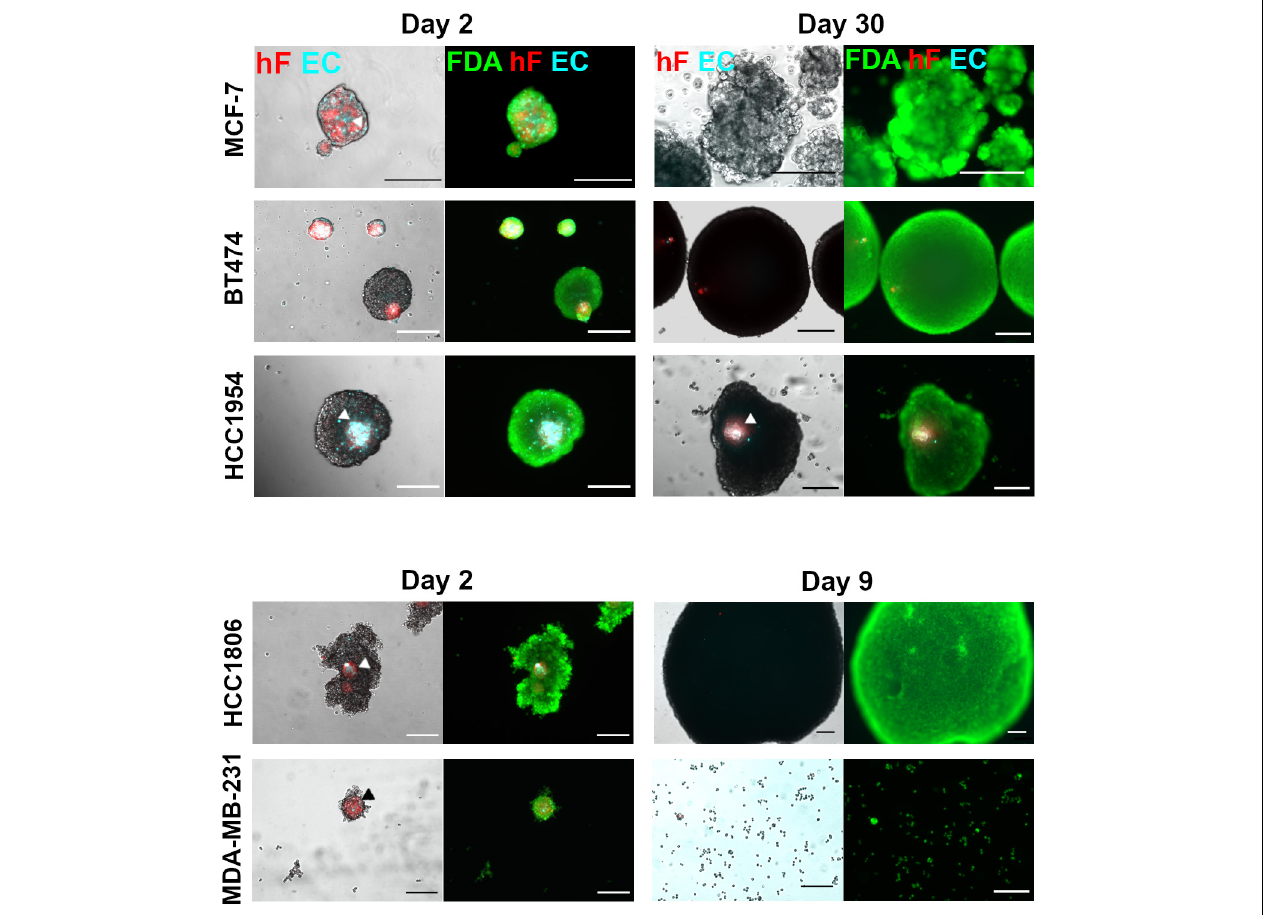
FIGURE 1 | Maintenance of ECs in triple heterotypic spheroids is tumor cell line dependent. Phase contrast and fluorescence microscopy of triple heterotypic spheroids in agitation-based cultures, at day 2 (after transfer to shake flasks) and day 30 of culture (after 2 days of aggregation in static culture followed by 28 or 7 days of agitation-based culture). HCC1806 and MDA-MB-231 spheroid cultures were terminated at day 9 (day 7 in agitation-based culture). Spheroids of breast cancer cell lines (TC); human dermal fibroblasts, labeled with PKH26 (hF, red); HUVEC, labeled with CellTracker Deep Red (EC, cyan), in a TC:hF:EC ratio of 1:1:1 (6,000 cells per well). Live cells were labeled with FDA (green). White and black arrowheads identify EC and hF in triple heterotypic spheroids. Images are representative of the 5–10 spheroids assessed per condition, in each of the three independent experiments performed ( N = 3). Scale bar, 250 µ m.